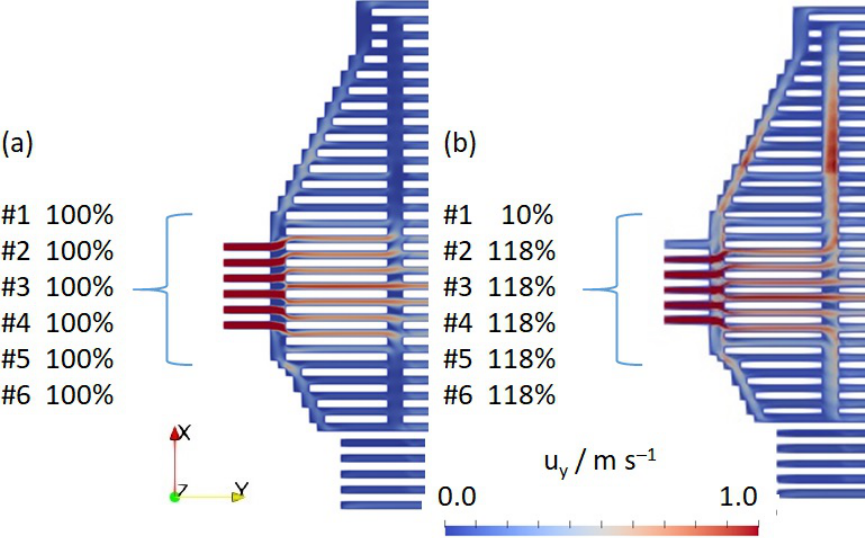
Figure 17. Fluid velocity (y-component) for the manifold region of the anode plate (MAX condition); cross section at half anode channel depth. ( a ) Normal flow at the inlet channels and ( b ) partial blocking of channel